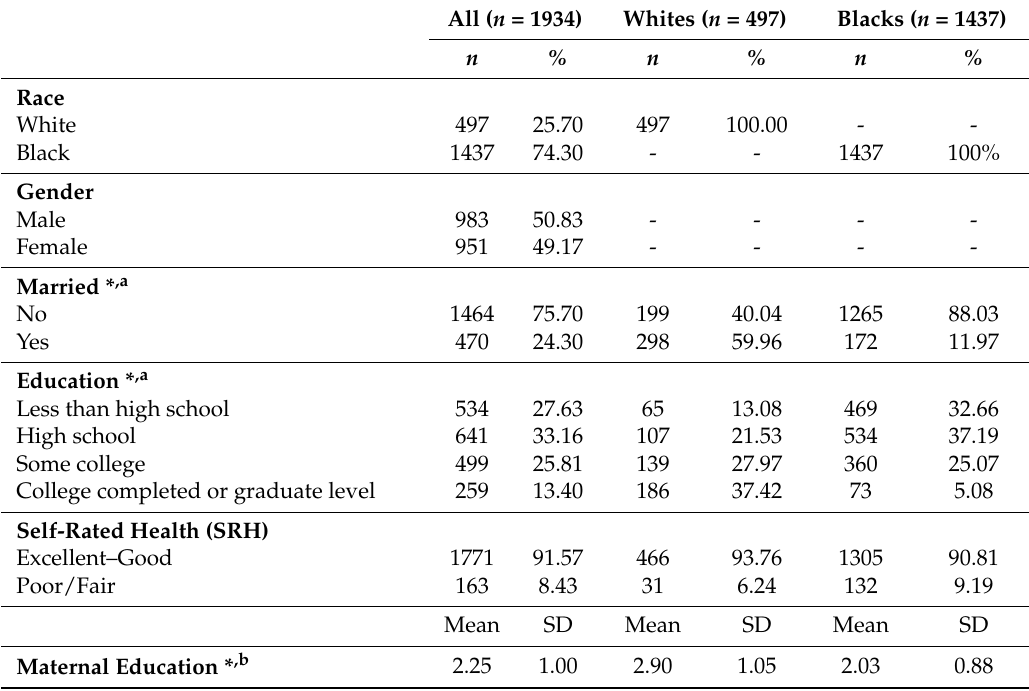
Table 1. Descriptive characteristics in the pooled sample and by